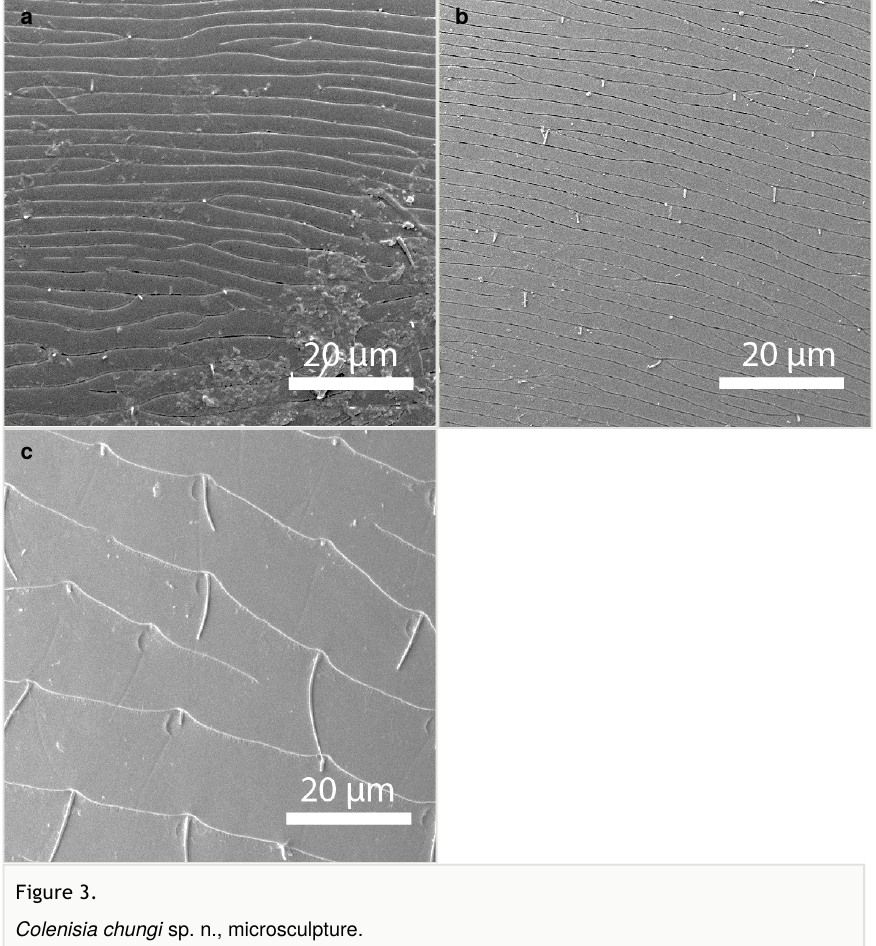
Figure 3. Colenisia chungi sp. n.,